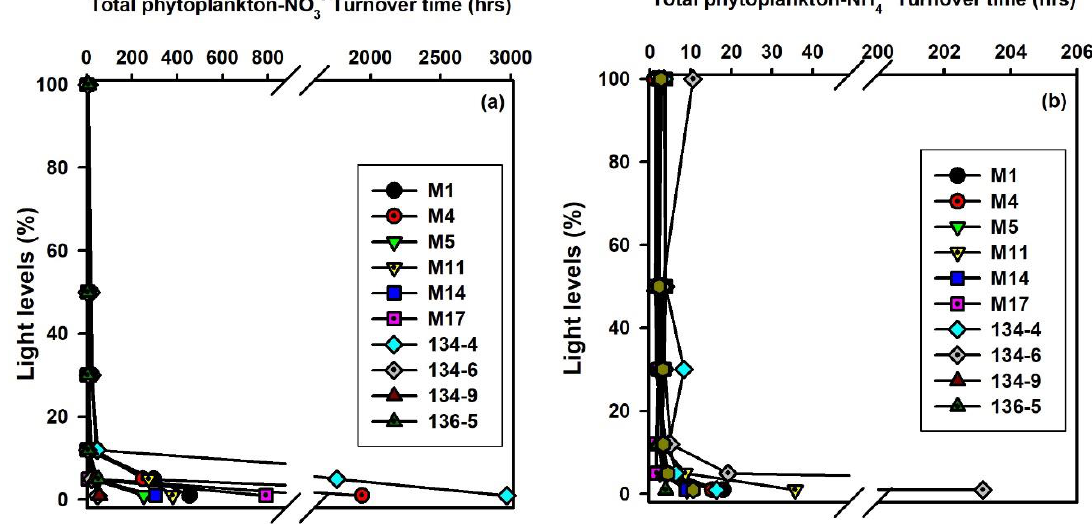
Figure 7. Depth profiles of ( a ) NO 3 − and ( b ) NH 4 + turnover time by total phytoplankton in the East / Japan Sea during 2012.